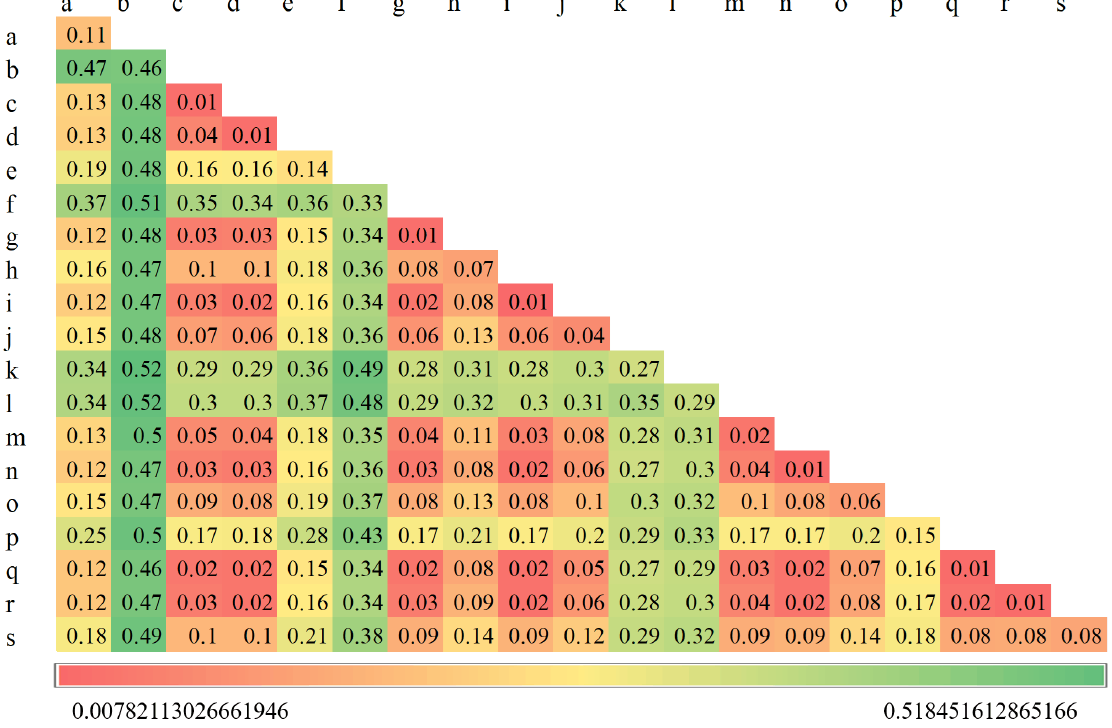
Figure 6. The interaction indices were calculated by Interaction detector (big value means strong interaction). Where a, b, . . . , s are settlement, elevation, aspect, fault, hails, land use, lithology, seismic density, fault, NDVI, plan curve, precipitation, river, road, slope, profile curve, soil erosion, TPI, SPI.